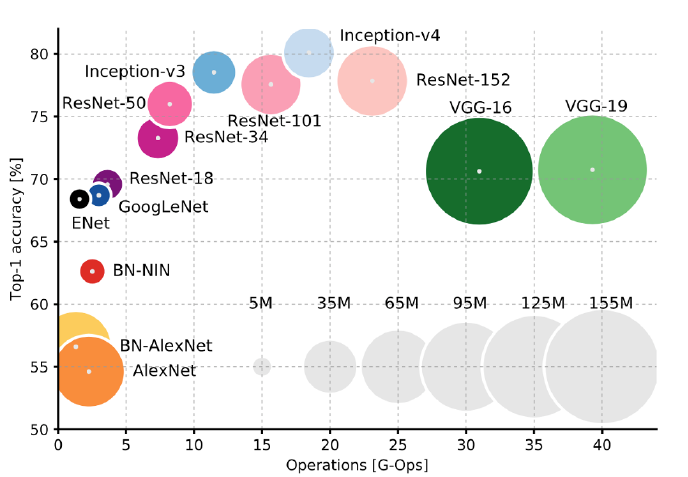
Figure 2. Comparison of different deep learning networks: Top-1 accuracy vs. operations size is being compared, as we can see that the VGG-19 have around 150 million operations, and operations size is proportional to the size of the network parameters. Inception-V3 shows promising results and has a smaller number of operations as compared to VGG-19. That was the motivation to choose these two networks for our research [30].